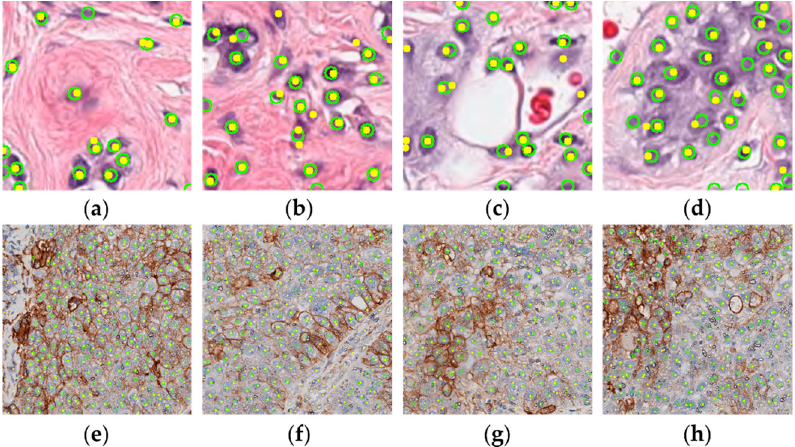
Figure 8. Visualized detection results of GeoNet on PanNuke and LUSC. ( a – d ) and ( e – h ) show nuclear localization in PanNuke and LUSC, respectively. Yellow dots stand for predicted locations and green circles for real locations.